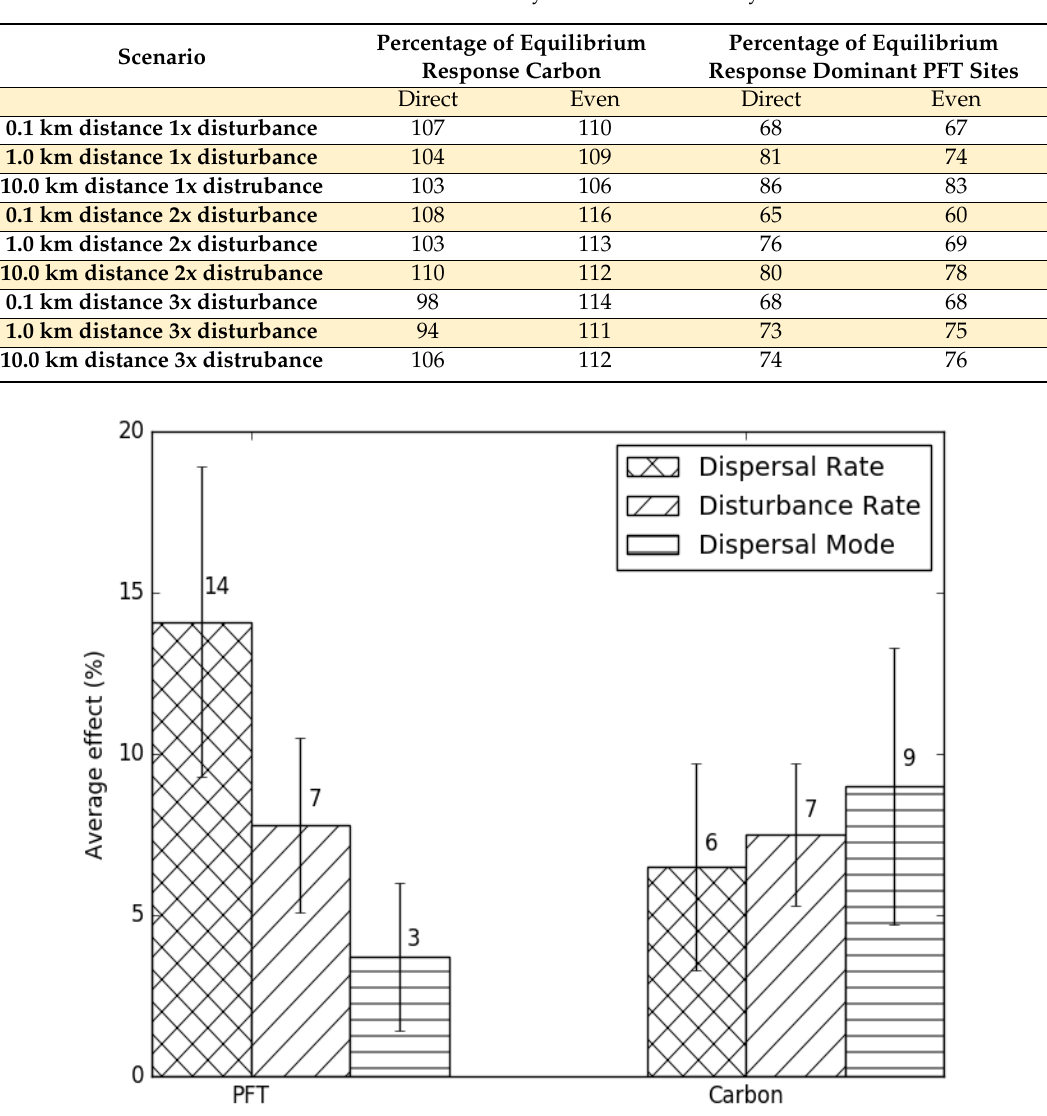
Figure 4. Maps of sites that contain biomass below the threshold of forest classification (in red) for directed ( A ) and even ( B ) dispersal at 0.1 km per year with a tripled disturbance rate.